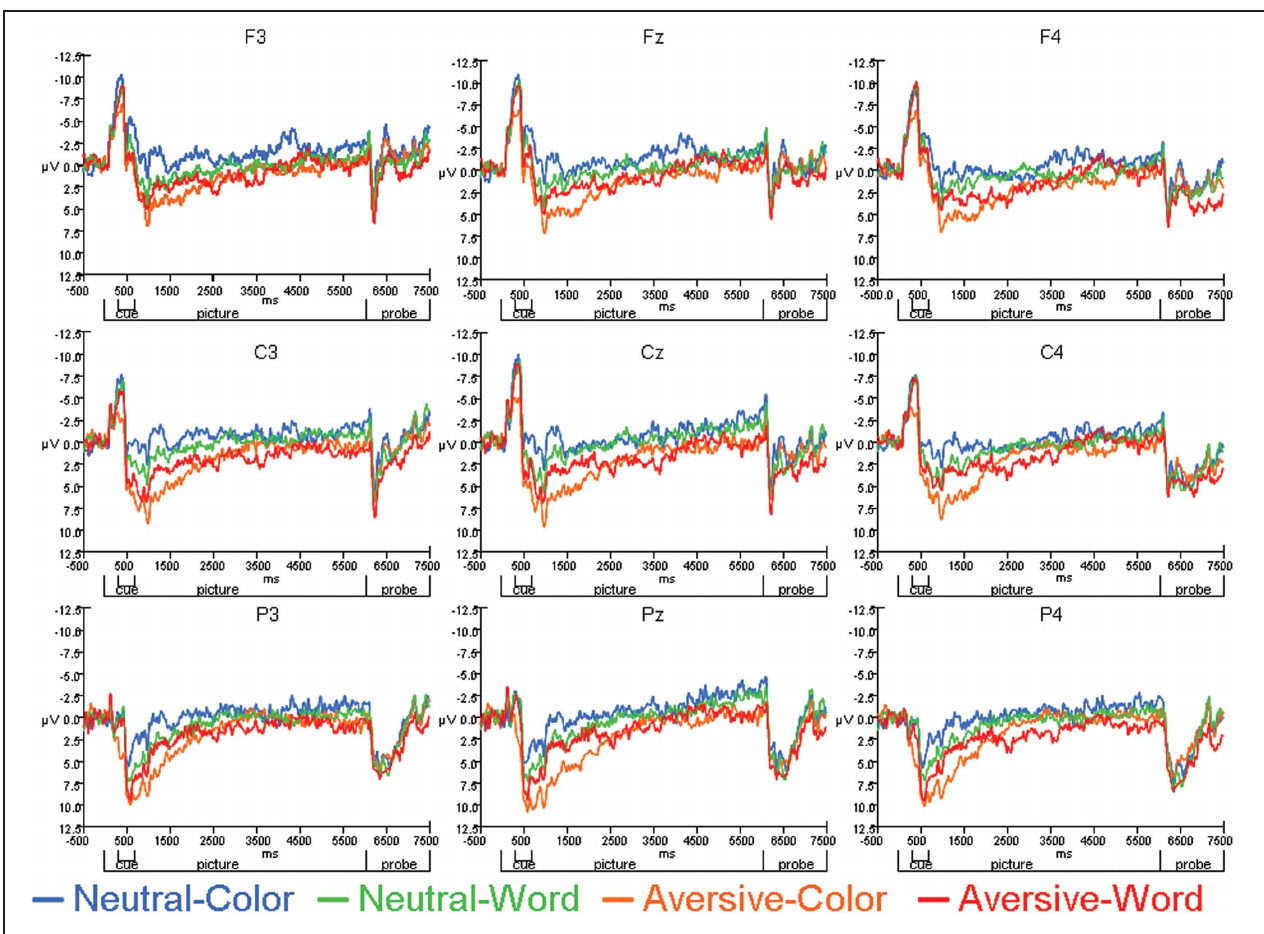
FIGURE 3 | Average ERPs for Neutral-Color, Neutral-Word, Aversive-Color, and Aversive-Word conditions across individual electrode